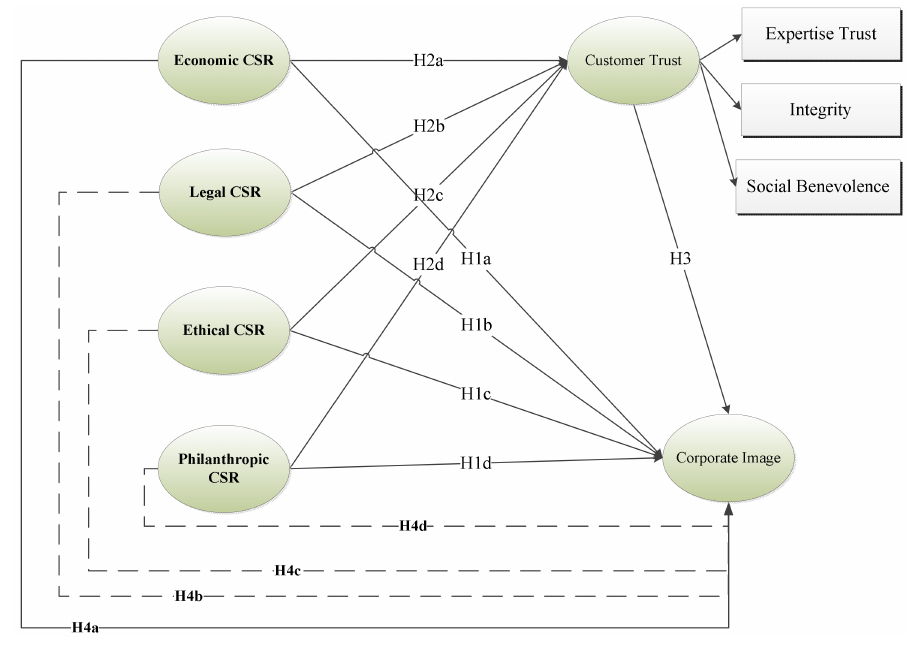
Figure 1. Theoretical